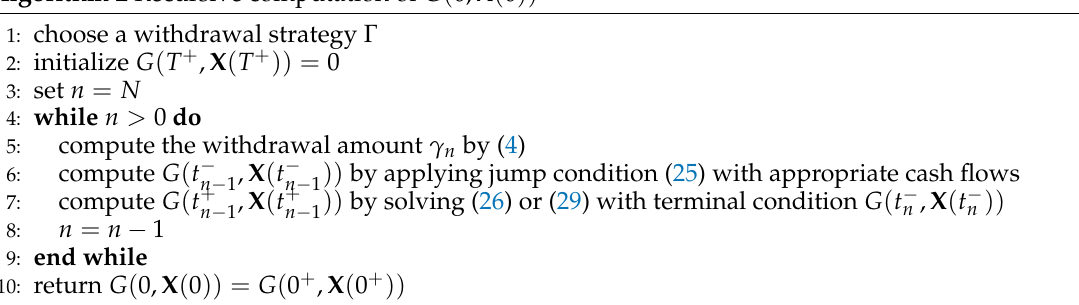
Algorithm 2 Recursive computation of G ( 0, X ( 0